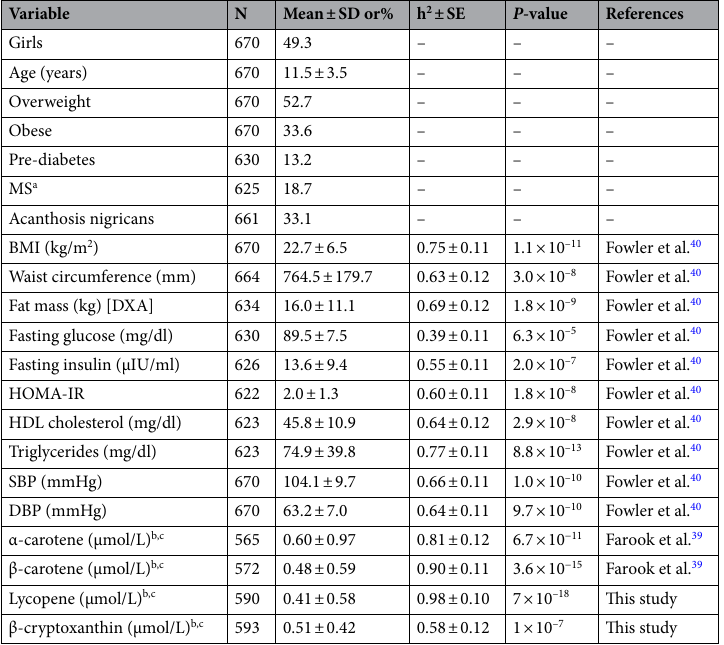
Table 1. Characteristics of the 670 non-diabetic SAFARI children and heritability estimates for selected cardiometabolic risk traits and carotenoids. BMI, body mass index; DXA, dual X-ray absorptiometry, HOMA-IR. the homeostasis model of assessment-insulin resistance; HDL cholesterol, high-density lipoprotein cholesterol; SBP, systolic blood pressure; DBP, diastolic blood pressure. a MS = metabolic syndrome as defined in Fowler et al. 40 . b Traits were inverse-normalized for the genetic analyses. c Traits were adjusted for the significant covariate effects of age and sex terms for the genetic